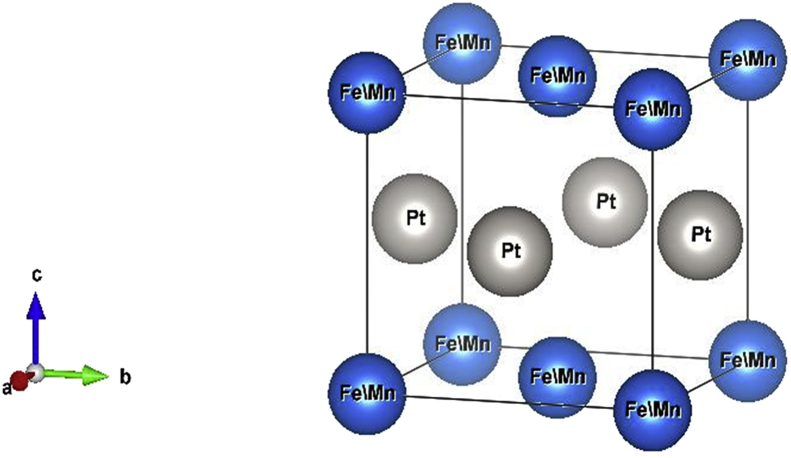
Schematic diagram of fct AuCu (L10) phase of FePt and MnPt ordered binary alloys.